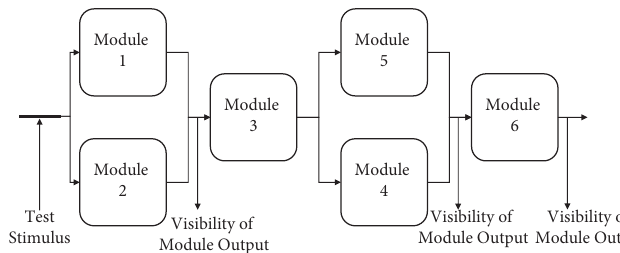
Figure 4: Fault diagnosis internal and external points.